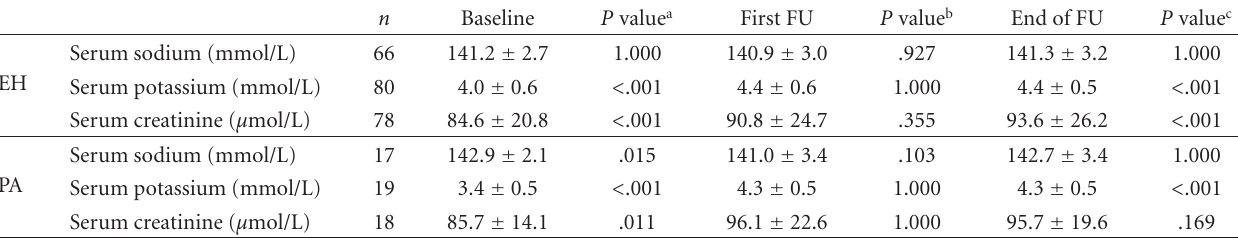
Table 2: Changes in biochemical parameters at first followup and end of followup after start of treatment with an aldosterone-receptor antagonist for patients with essential hypertension (EH) and primary aldosteronism (PA). (Values were tested with one-way ANOVA for repeated measurements. Indicated P values are for di ff erences between baseline and first followup (a), first and last followup (b), and baseline and last followup (c) after Bonferroni adjustment; n represents the number of patients with measurements at all three time points). n Baseline P value a First FU P value b End of